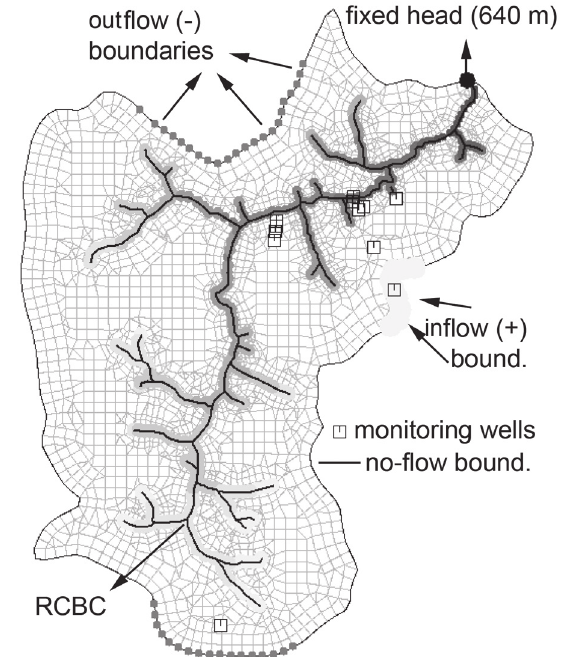
Figure 3 - SPA model domain of OCB and its boundary conditions: inflow and outflow boundaries. Drainages were set as RCBC (Robin-Cauchy Boundary Condition), except for the outlet point, set as a fixed head so the model would provide a single unique